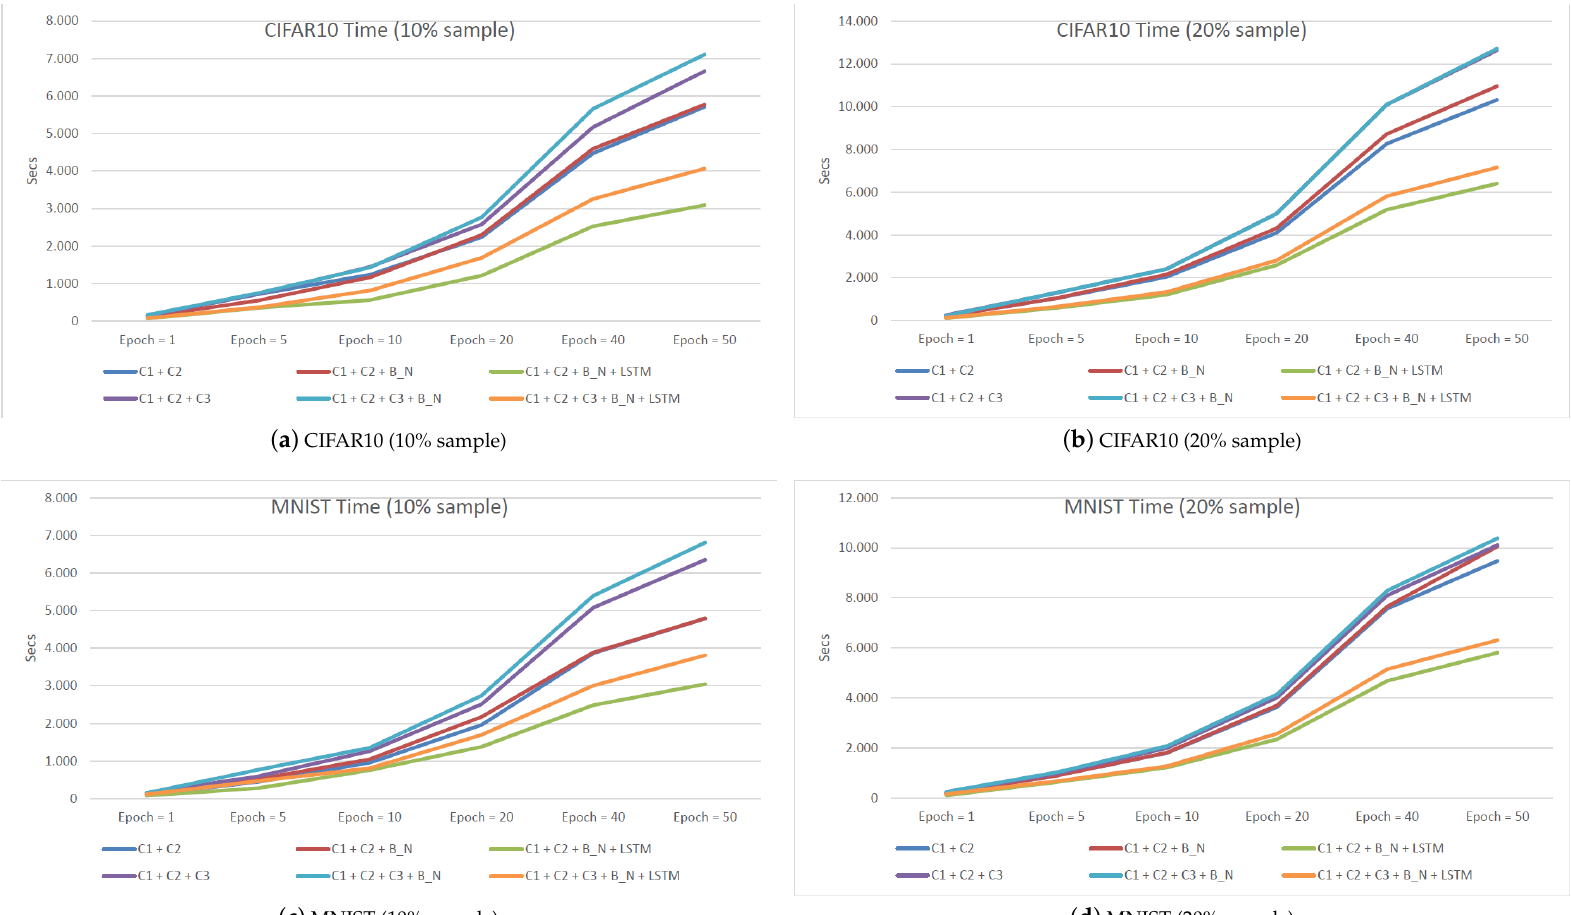
Figure 3. Time (s) for different numbers of epochs for CIFAR10 and